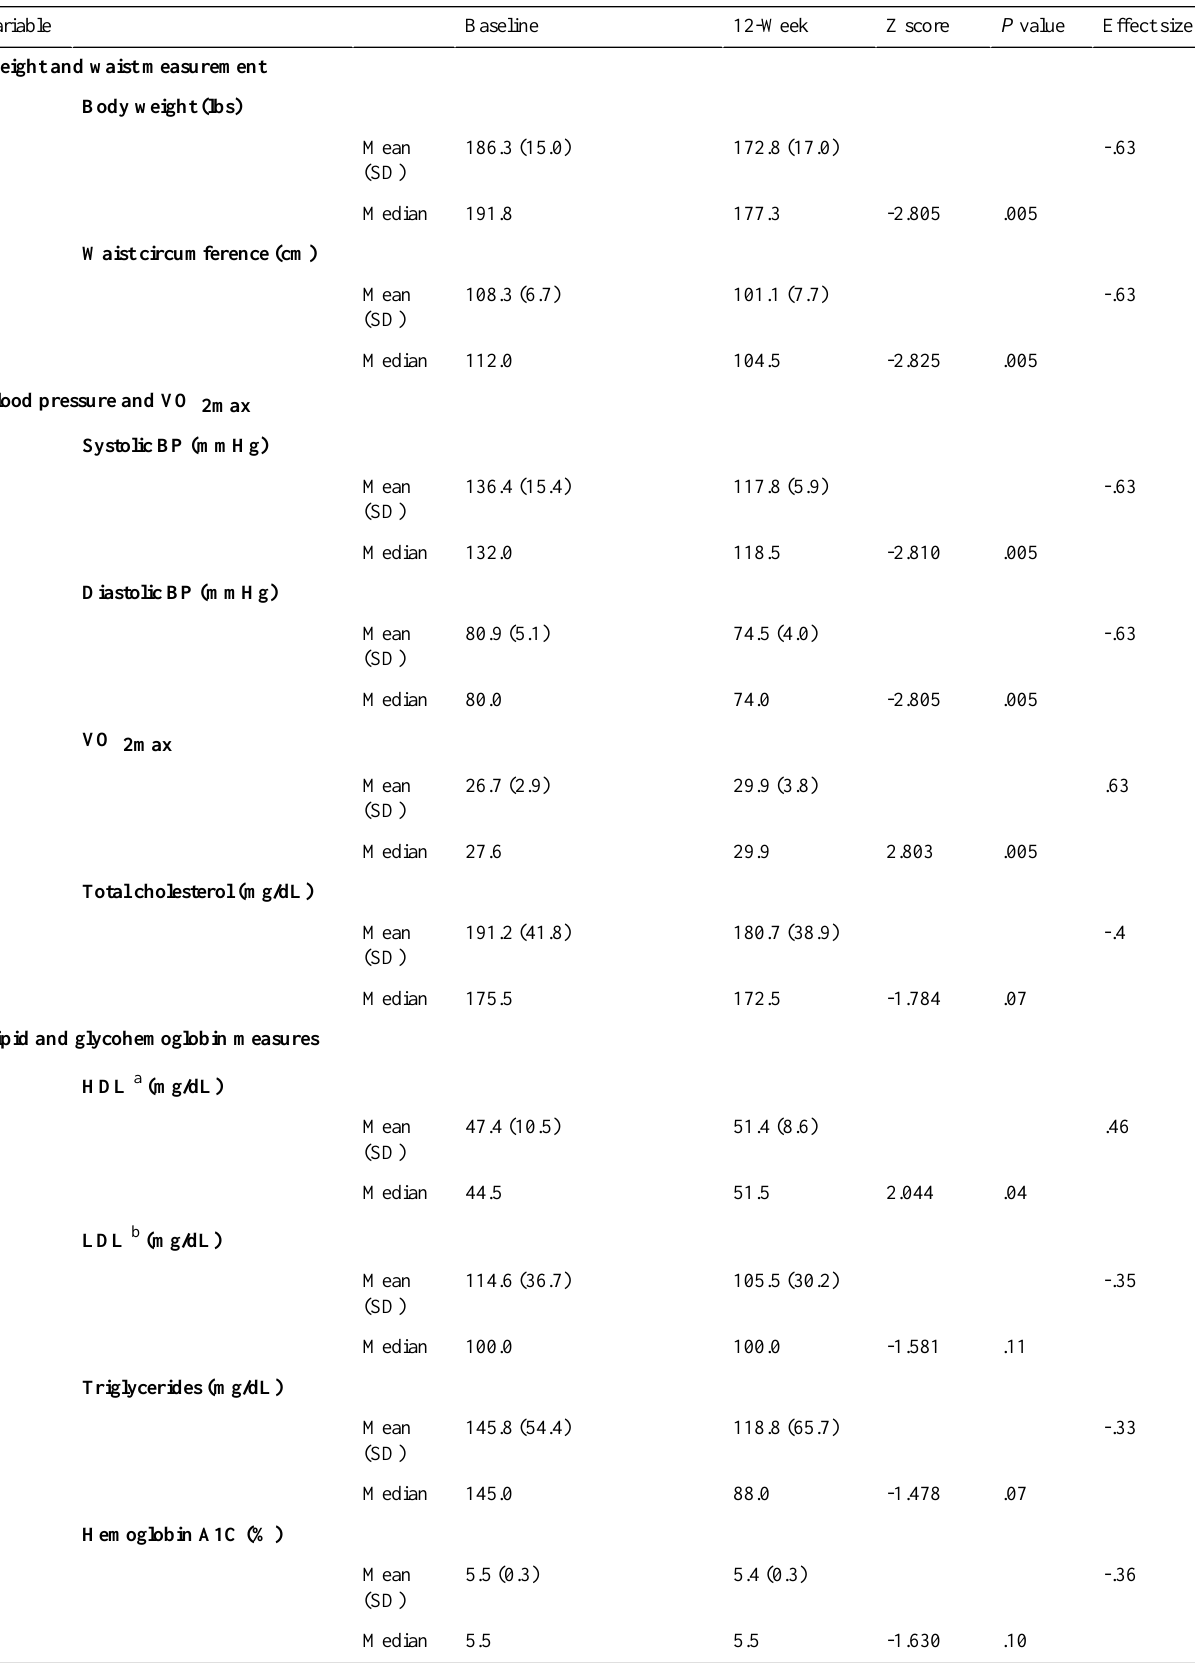
Table 2. Baseline and 12-week values for all outcome